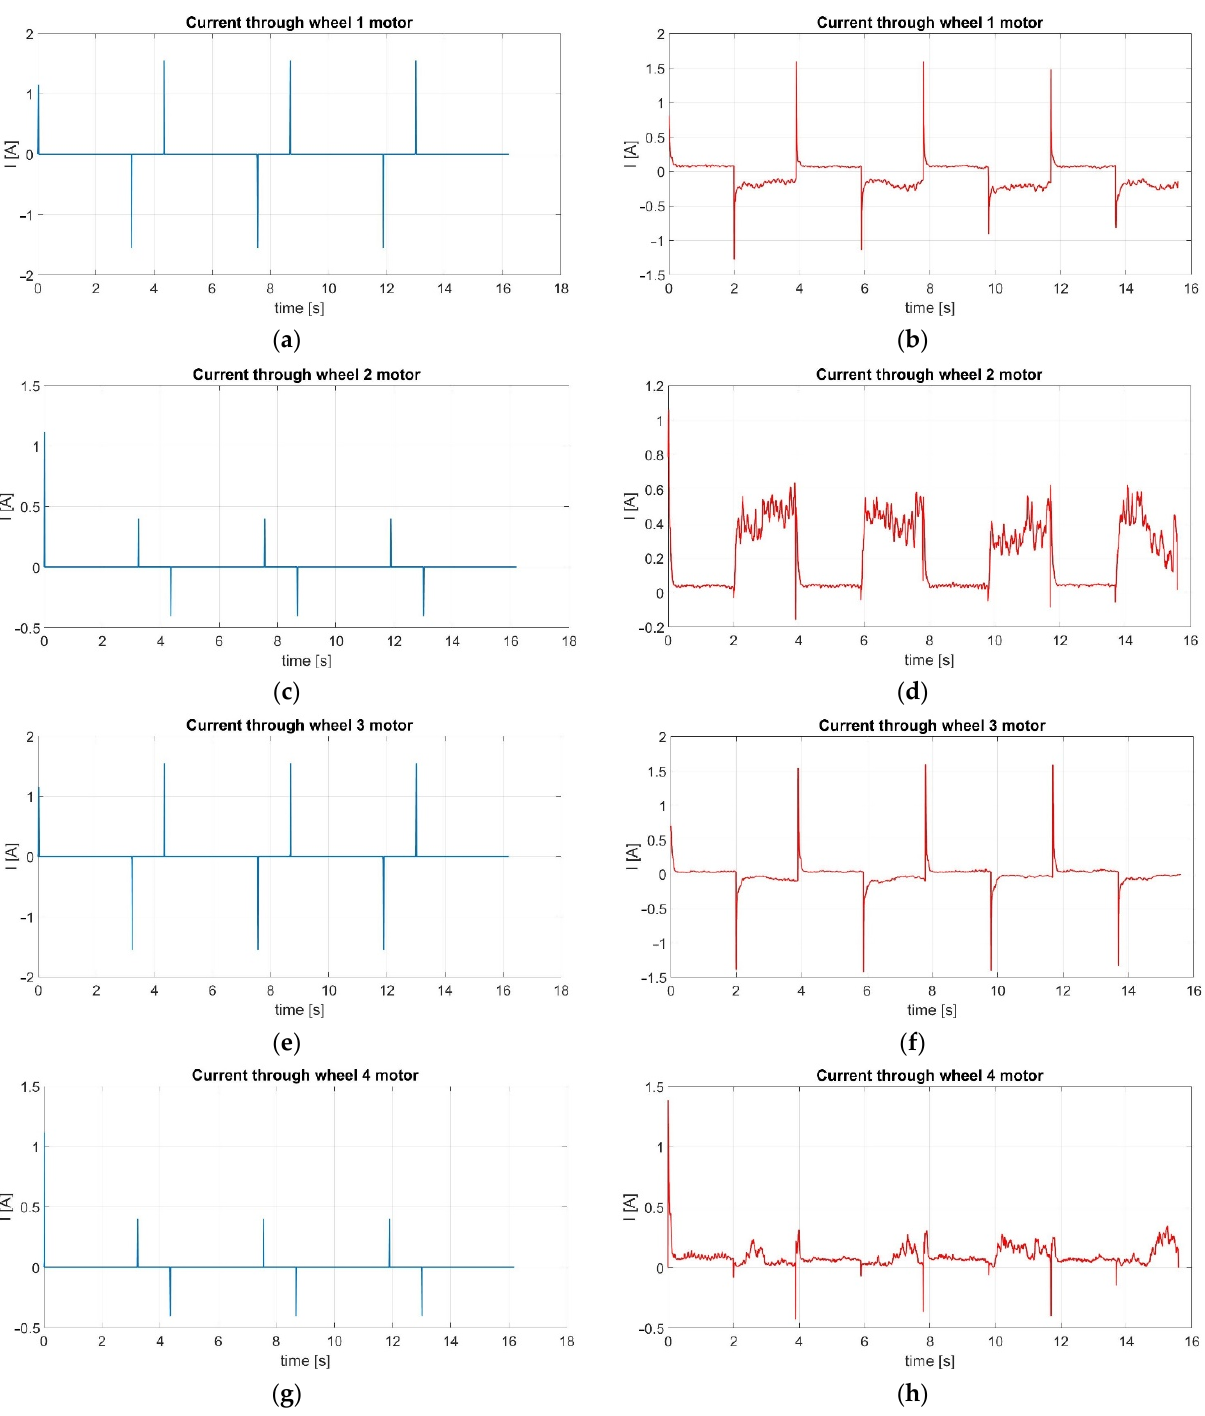
Figure 14. Comparison between simulated ( a , c , e , g ) and measured ( b , d , f , h ) currents through the wheel motors for the differential drive with loop kinematic solution: ( a , b ) wheel 1; ( c , d ) wheel 2; ( e , f ) wheel 3; ( g , h ) wheel 4.